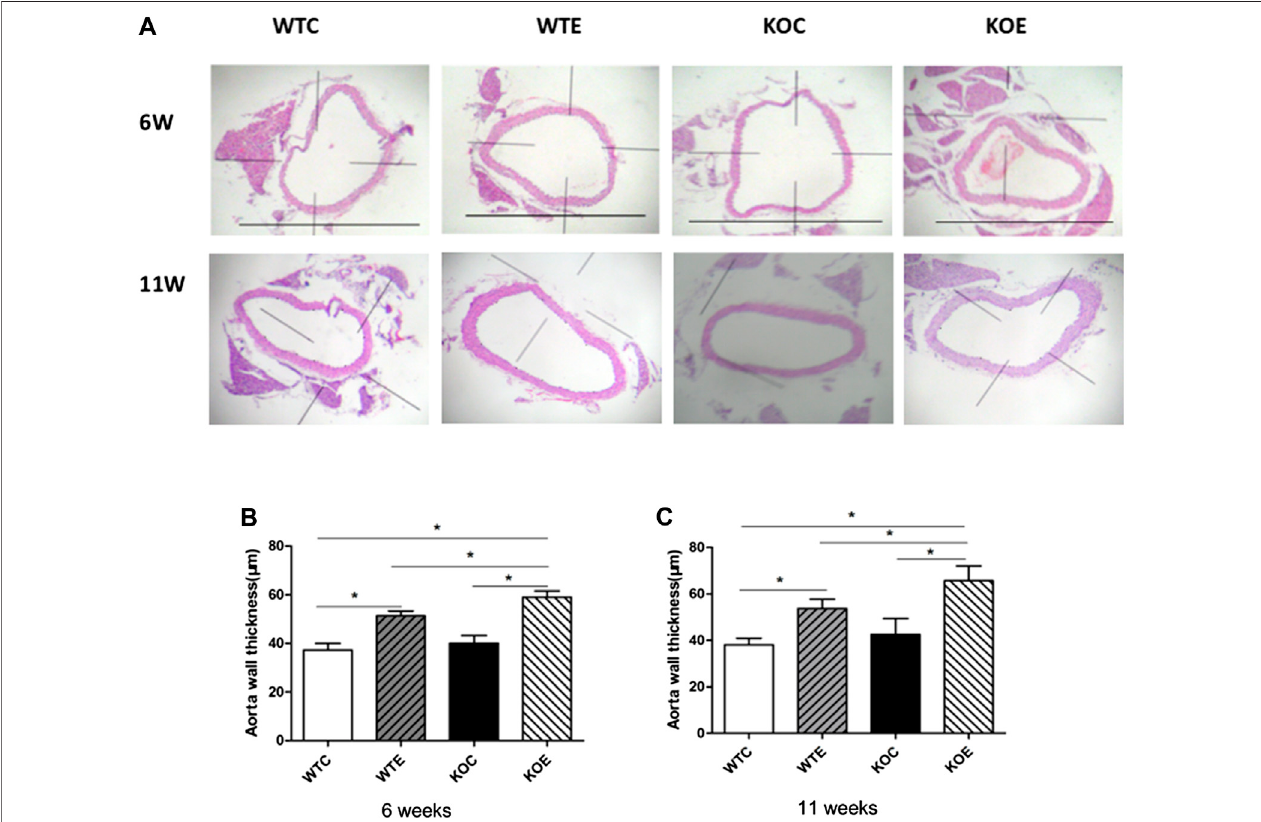
FIGURE 1 | Histopathology results 6 – 8 weeks C57/B6 mice, with or without Nrf2 knockout were exposed to either fi ltered air or air containing particulate matter (PM) for six or eleven weeks, and then the vascular tissue samples were fi xed in 4% paraformaldehyde for 24 h, and then histologically processed for hematoxylin and eosin staining.The right vascular wallthickness wasthen measured and analyzed. N (cid:2) 6 per group.WTC wasC57wild-typecontrolgroup, WTE wasC57wild-type PM exposuregroup,KOCwasNrf2-/-groupcontrolgroup,andKOEwasNrf2-/-groupPMexposuregroup.*:statisticallydifferentbetweenthetwogroups( p < 0.05). (A) : Representative hematoxylin and eosin stained sections for WT-C, WT-E, KO-C, and KO-E groups after 6- or 11-weeks treatment. Scale bars represent 1,000 um. (B) : Quanti fi cation of the aorta wall thickness following 6-weeks. (C) : Quanti fi cation of the aorta wall thickness following 11-weeks